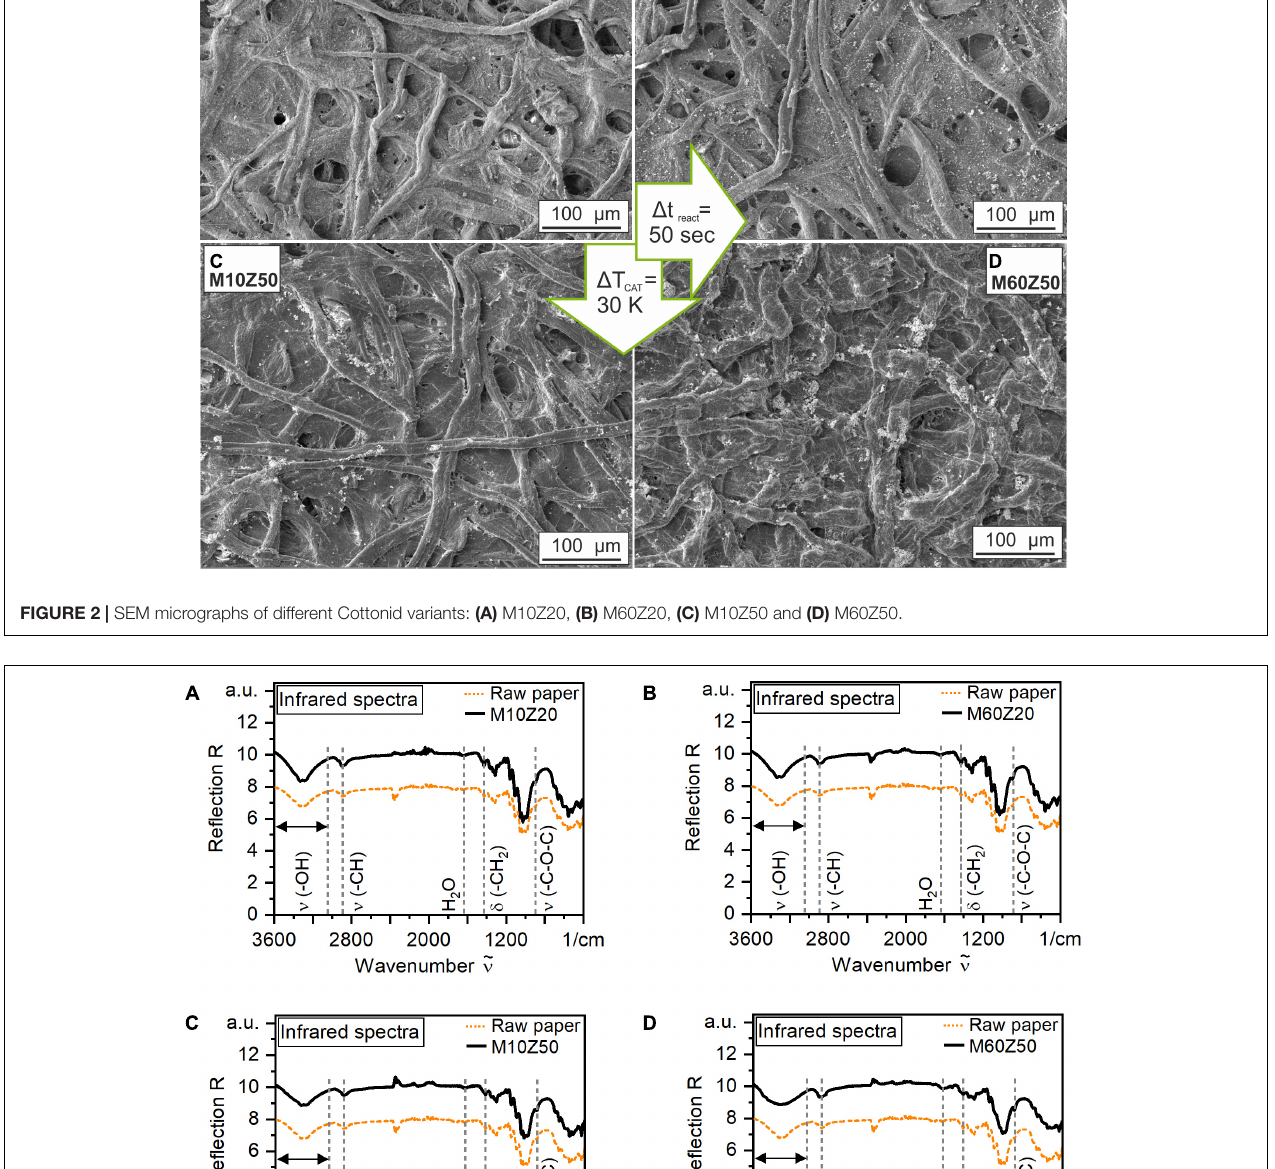
the stretching vibrations of the hydroxyl group [ ν (–OH)] of the cellulose chains can be seen. The height and area of the peak therefore provides information about the inter-